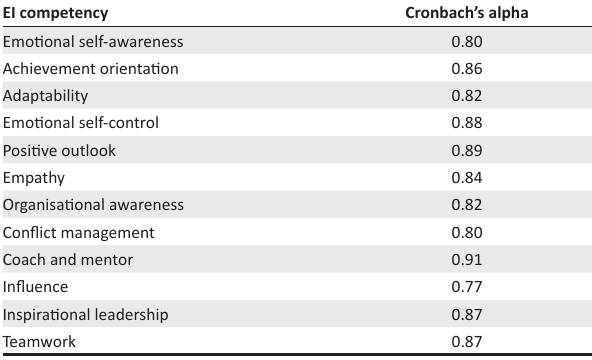
TABLE 3: Cronbach’s alpha coefficients for Emotional and Social Competence Inventory